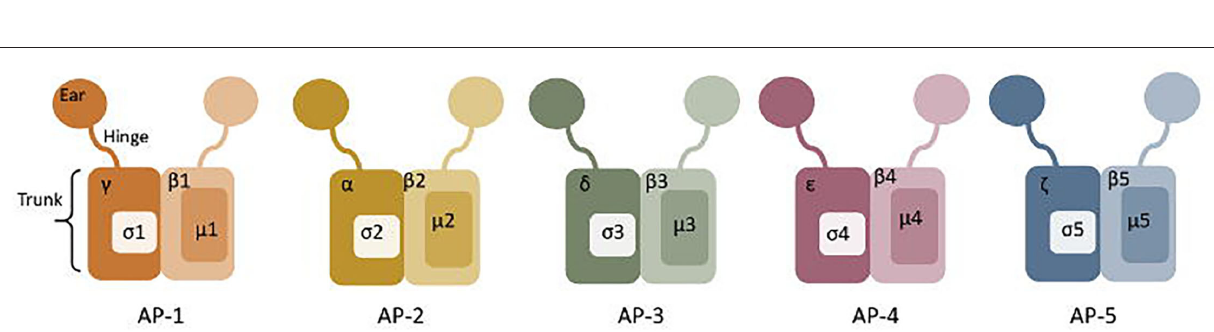
FIGURE 4 | Schematic diagram of CCV formation occurring in the following steps; Nucleation, cargo selection, coat formation, vesicle scission, and uncoating.